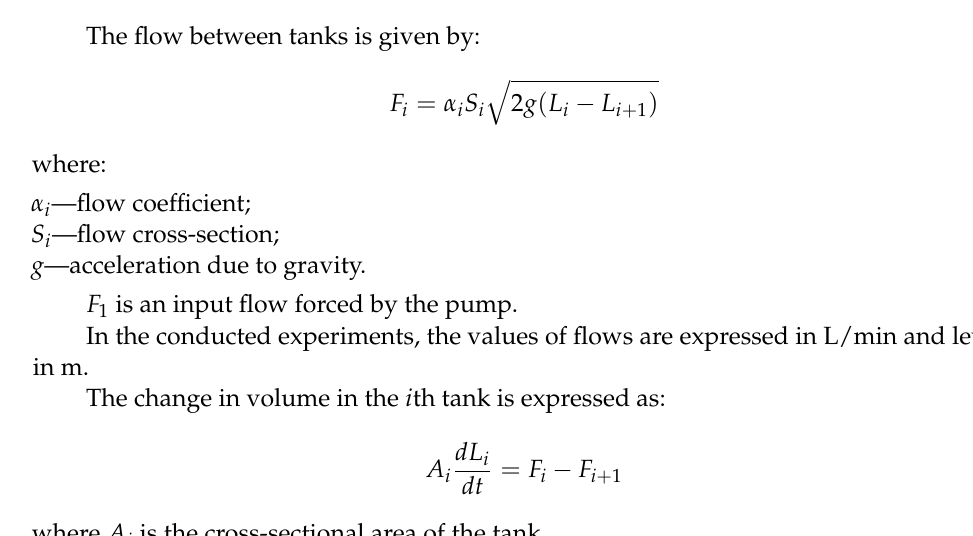
Figure 2. Diagnosed process—a set of serially-connected liquid buffer tanks. Physical variables available for measurement are placed in the black